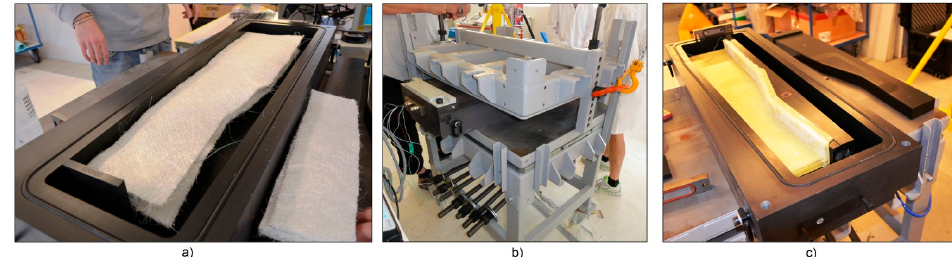
Figure 3. RTM production process of the A380 hinge arm: lower half-mould during preform preparation ( a ); clamping frame used to seal the mould ( b ) and hinge arm demoulding ( c ).